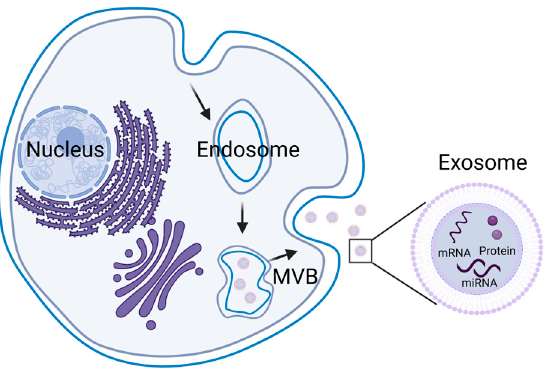
Figure 1. The origin and constituent of exosomes. Inside the cell, exosomes originated from the formed multivesicular bodies (MVBs) from endosomes. Their constituent comprises phospholipids, mRNA, miRNA, and proteins.